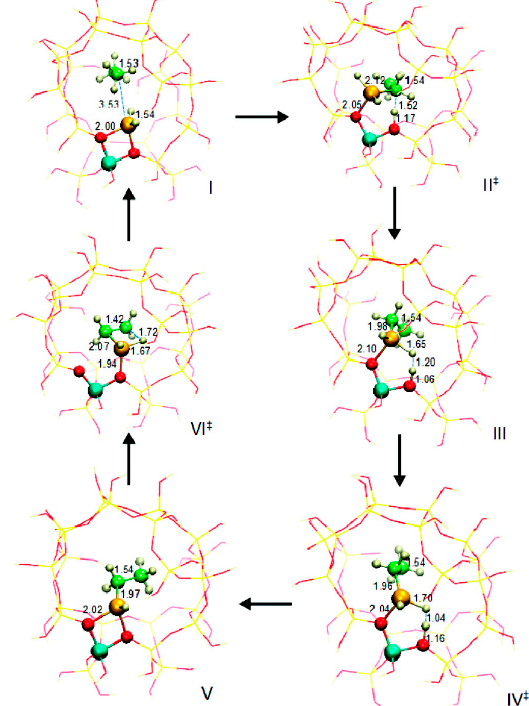
Figure 17. Transition state for the dehydrogenation reaction of ethane through the concerted mechanism. Reprinted with permission from ref [132]. Copyright 2005 Elsevier.